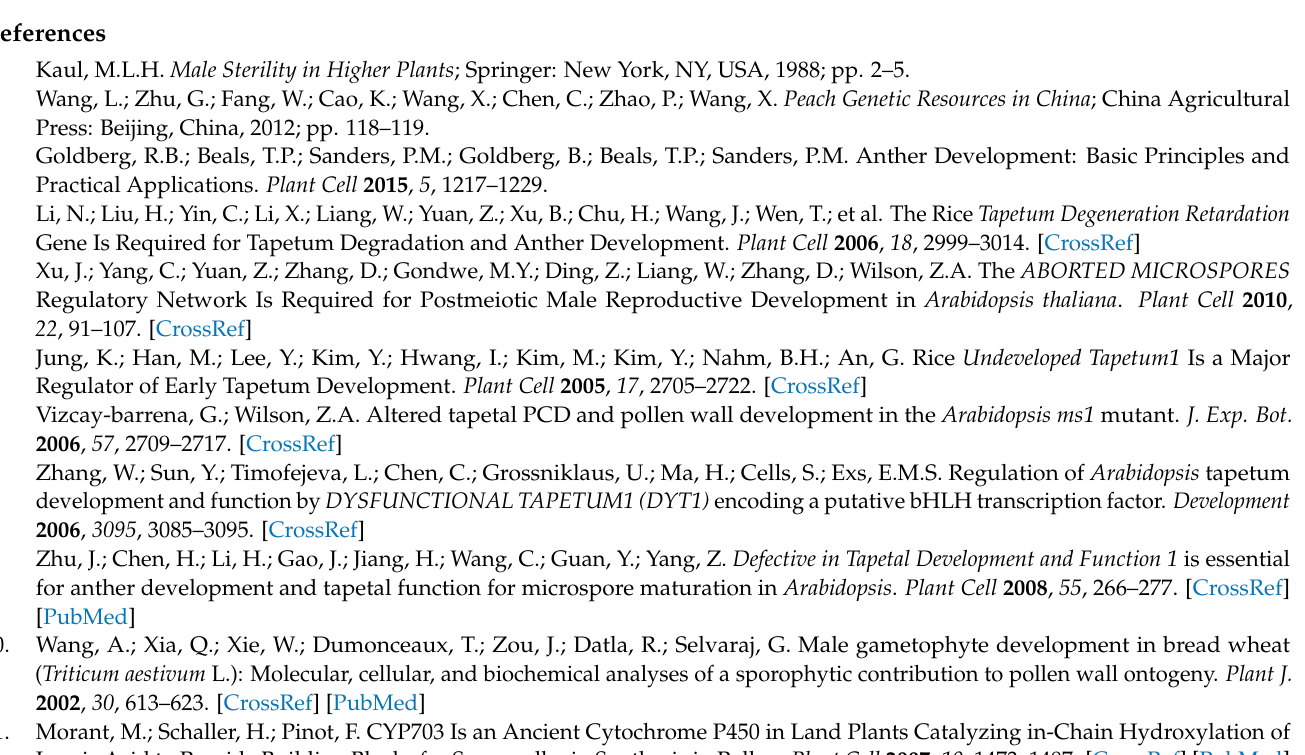
Supplementary Materials: Figure S1. Sequence alignments of ABCG26 proteins of Arabidopsis ( Arabidopsis thaliana ), peach ( Prunus persica ), apricot ( Prunus armeniaca ), Chinese plum ( Prunus salicina ), sweet cherry ( Prunus avium ), apple ( Malus domestica ), and rice ( Oryza sativa ). Table S1. Sequencing information of the 201 peach accessions used for GWAS analysis. Table S2. Gene-specific primers for